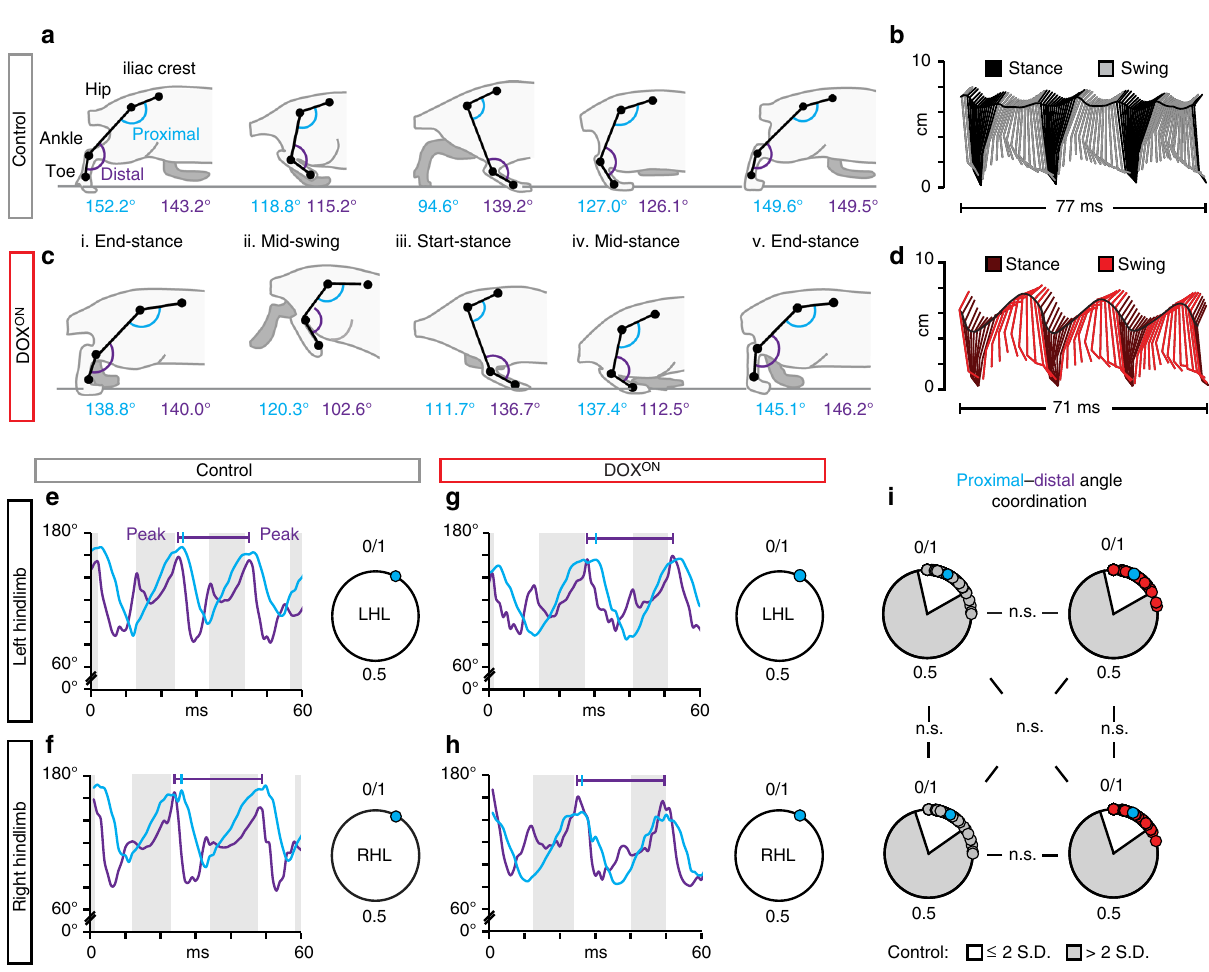
Fig. 2 L2 – L5 interneurons are dispensable for intralimb coordination during locomotion. Representative illustrations of intralimb movements during a control and c DOX ON stepping, as described by three hindlimb segments (iliac crest – hip, hip – ankle, and ankle – toe) and two hindlimb angles (proximal (blue): iliac crest – hip – ankle angle, distal (purple): hip – ankle – toe angle). Proximal and distal angles are shown for fi ve select instances throughout one step cycle. b , d Two-dimensional stick fi gures of hindlimb stepping at Control and DOX ON time points, respectively (from the same stepping passes shown in ( a , c ); sampling rate = 100 Hz). Silencing L2 – L5 interneurons increased vertical movements in the hip ( d , black horizontal trace) while preserving normal hindlimb range of motion (Supplementary Figure 2). Onset times of peak angular excursions ( e – h , blue and purple hashmarks) were analyzed to assess the temporal coordination between proximal and distal angles (see Methods for detail) (traces = excursions of proximal and distal angles; shaded region = stance phase; 0/1 in circular plot denotes normal, in phase coordinated movements; individual circles = intralimb coordination value for one step cycle; LHL left hindlimb; RHL right hindlimb). i Proximal-to-distal intralimb movements of the left and right hindlimb (as well as between limb pairs) remained unaffected during silencing ( n = 130 and 150 intralimb cycles for collapsed Control and DOX ON time points, respectively; white inset = normal variability at control time points). All comparisons in ( i ) were p > 0.5 (Watson ’ s nonparametric two-sample U 2 test; LHL: Control vs. DOX ON U 2 = 0.04232; RHL: Control vs. DOX ON U 2 = − 0.13874; Control: LHL vs. RHL U 2 = − 0.00653; DOX ON : LHL vs. RHL U 2 = 0.01623; Control LHL vs. DOX ON RHL: U 2 = 0.04225; Control RHL vs. DOX ON LHL: U 2 = 0.04232). Illustrations by A.